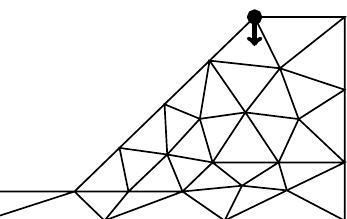
Figure 23. The vertical displacement, indicated with an arrow, of the upper left node as the QoI for model problem 2.